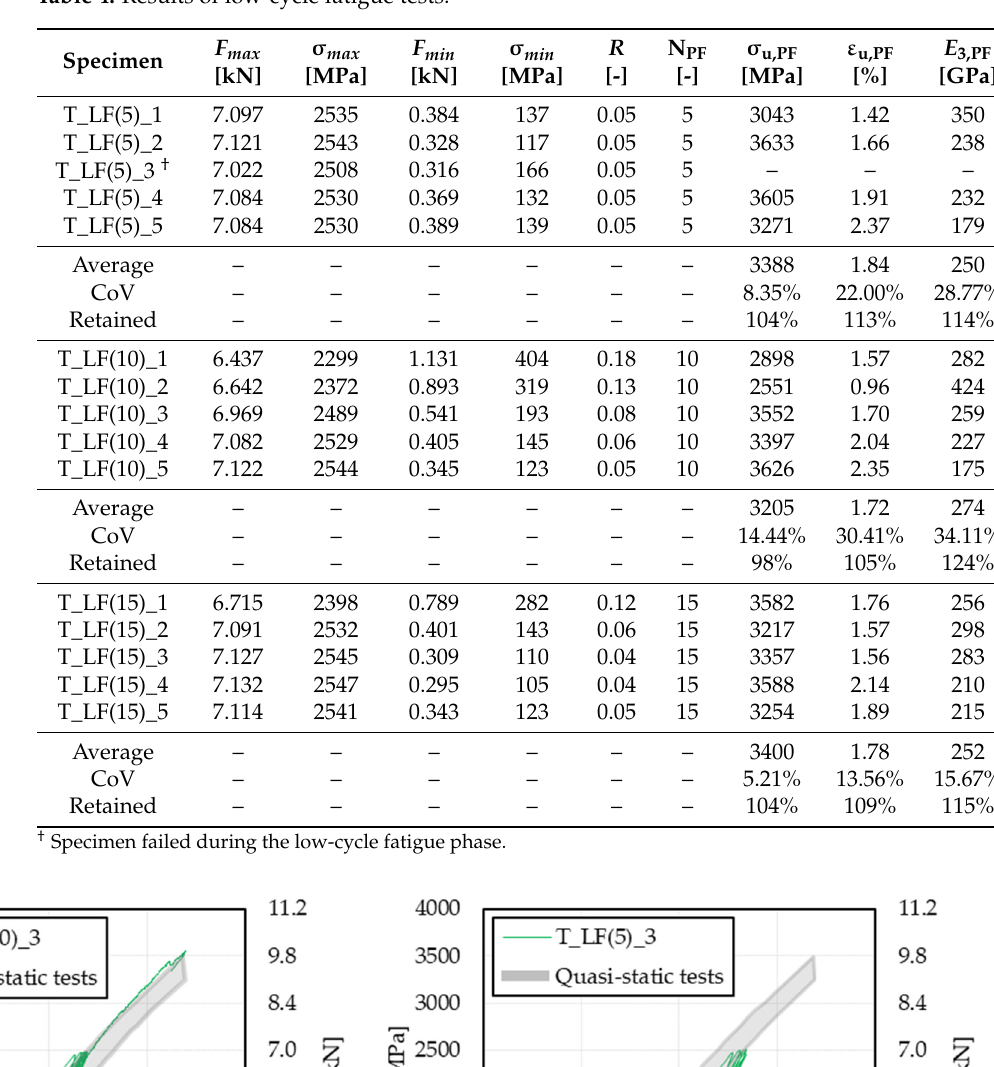
Table 4. Results of low-cycle fatigue tests.